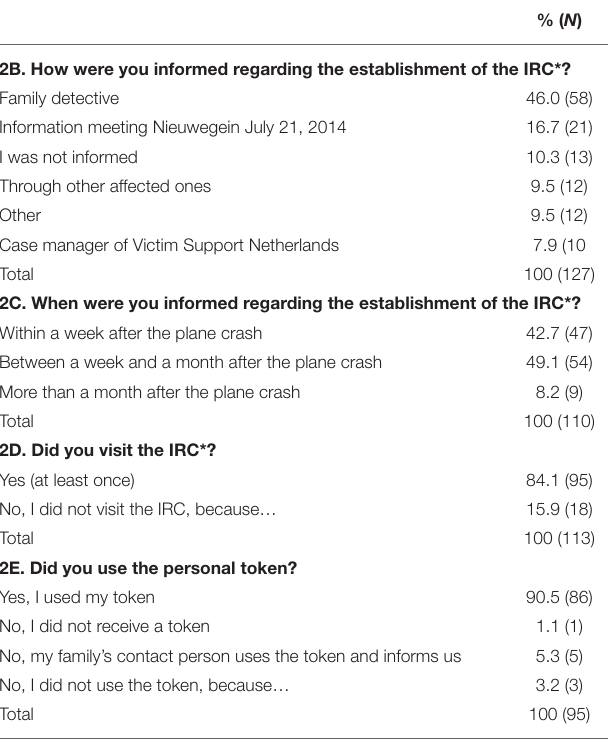
TABLE 2B–E | Survey results of affected ones (data source